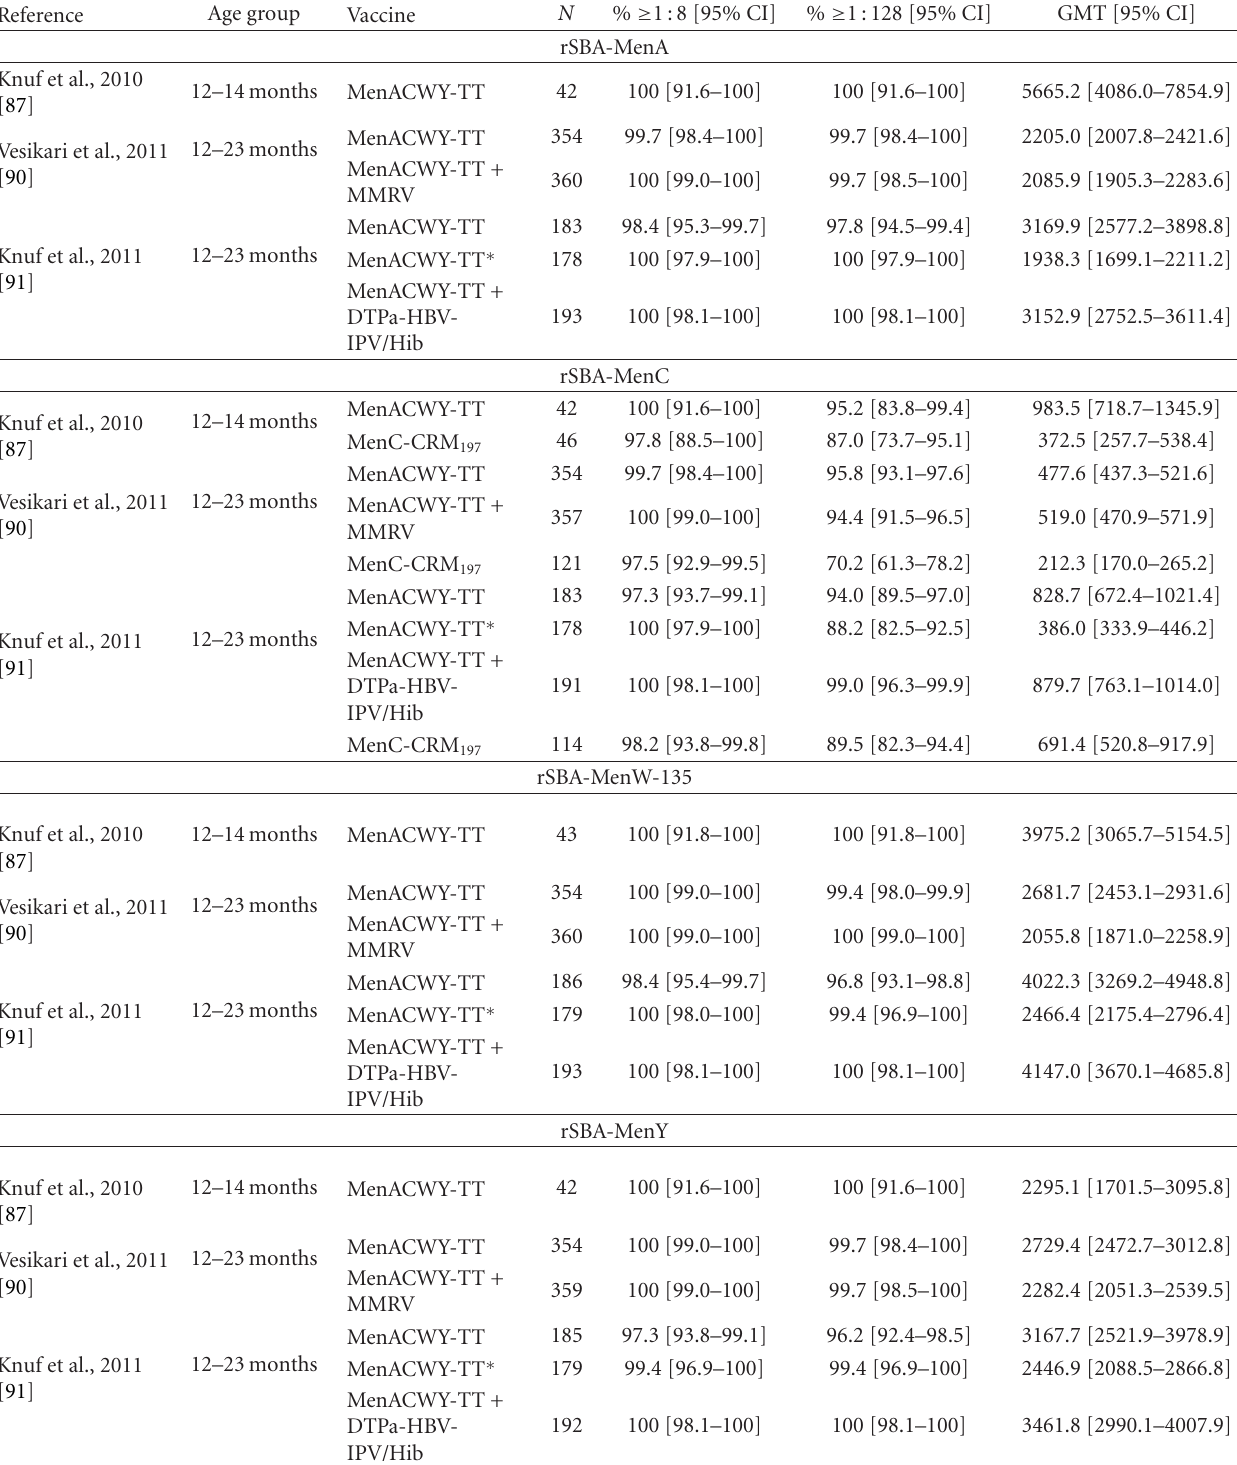
Table 5: rSBA-MenA, rSBA-MenC, rSBA-MenW-135, and rSBA-MenY antibody response one month [87, 91] or 42 days [90] after one dose of MenACWY-TT in toddlers (ATP immunogenicity